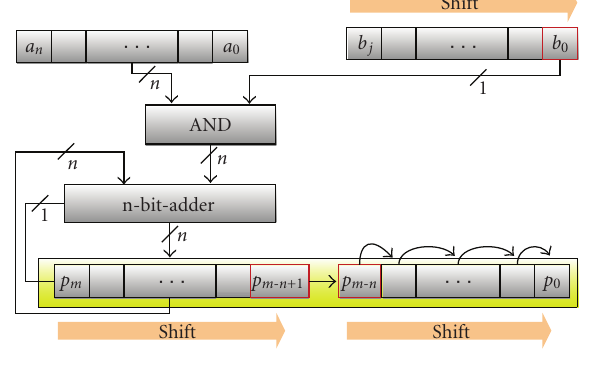
Figure 5: Sequential multiplier.